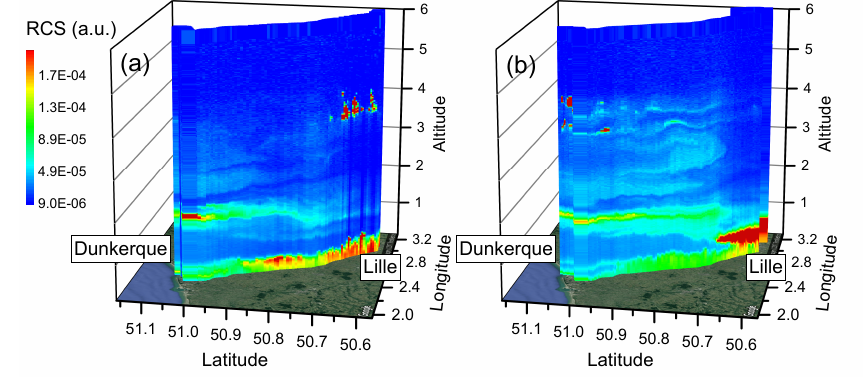
Figure 6. Three-dimensional view on the spatio-temporal variability of the LiDAR range-corrected signals measured along the (a) Lille– Dunkerque and (b) Dunkerque-Lille transects on 26 August 2016. Observed structures: PBL up to 1km altitude, elevated aerosol layers between 2 and 5km and scattered clouds at 4km near Lille and Dunkerque in